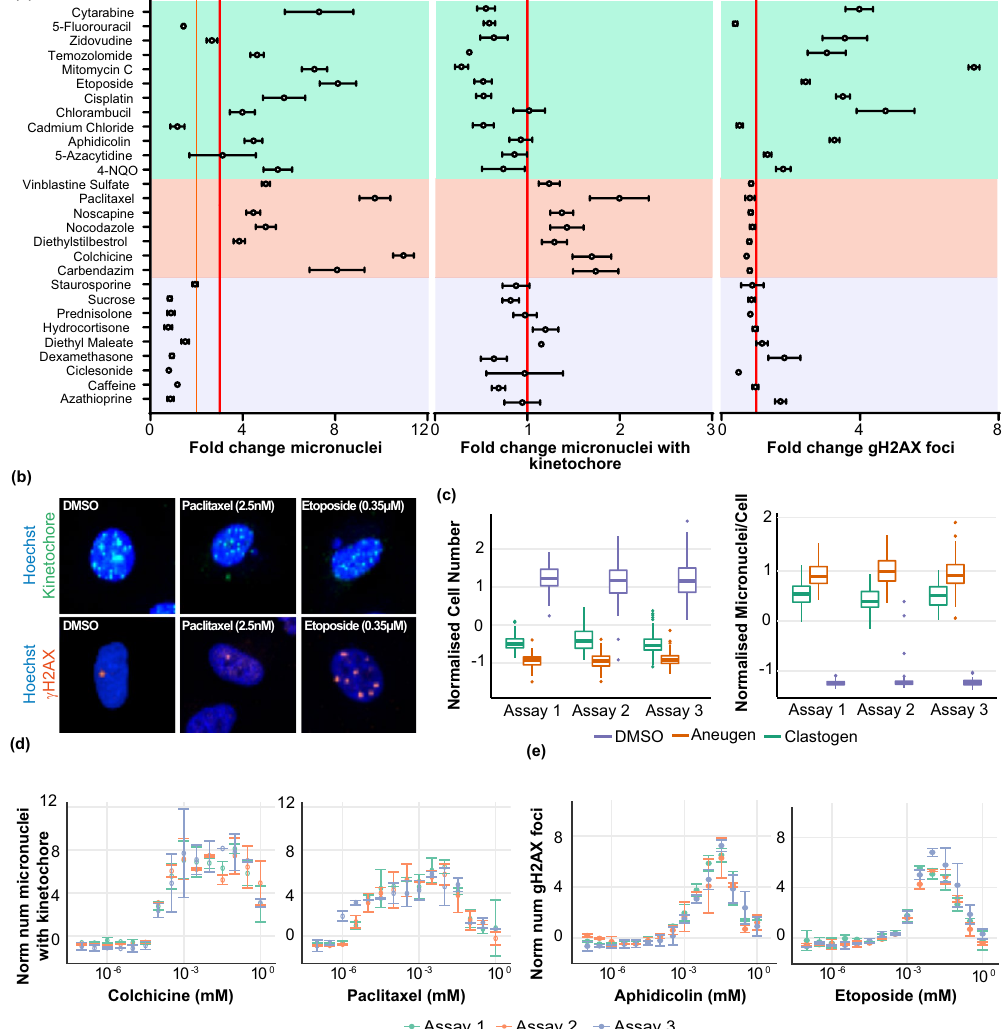
Figure 2. Validation of a high content in vitro micronucleus assay. ( a ) Normalised (c.f inter-plate DMSO wells) response (mean ± SEM) of validation compounds at the assay limit dose, illustrated are fold change in micronucleus per cell, fold change in kinetochore positive micronuclei per cell and fold change in γ.H2AX foci/nucleus. Non-genotoxic chemicals: purple shading, aneugenic chemicals: orange shading and clastogenic chemicals: green shading (n = 3, except Staurosporine and Zidovudine n = 2 and 5 ′ Fluorouracil n = 4). ( b ) Representative images from plate control wells, cells treated with DMSO, Paclitaxel (2.5 nM) or Etoposide (0.35uM), DNA (Hoechst, blue), Kinetochore (CREST, green) and γ.H2AX foci (γ.H2AX, orange). ( c ) Intra- assay reproducibility for inter-plate controls and MOA assay endpoints. Variability in cell number and number of micronuclei (expressed as micronuclei/cell), when normalised to mean DMSO control across 3 independent assay runs (8 plates/run); negative control (DMS; purple-14 wells/plate), aneugenic control (Paclitaxel; green- 12 wells/plate) and clastogenic control (Etoposide; orange-12 wells/plate). ( d ) Fold change (normalised to inter-plate DMSO controls) in kinetochore positive micronuclei following treatment with known aneugens: Colchicine and Paclitaxel from 3 independent assay runs. ( e ) Fold change (normalised to inter-plate DMSO controls) in γ.H2AX foci per nuclei following treatment with known clastogenic chemicals: Aphidicolin and Etoposide from 3 independent assay